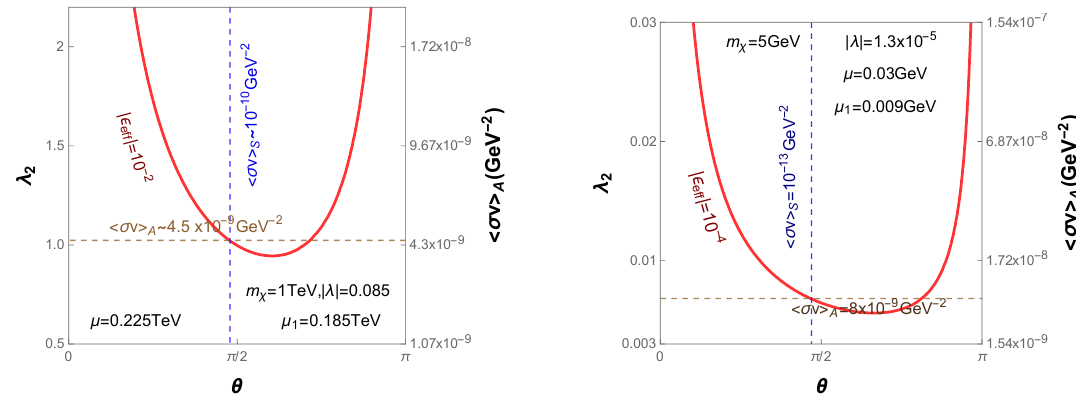
(cid:15) e(cid:11) (red solid lines), as a function j j